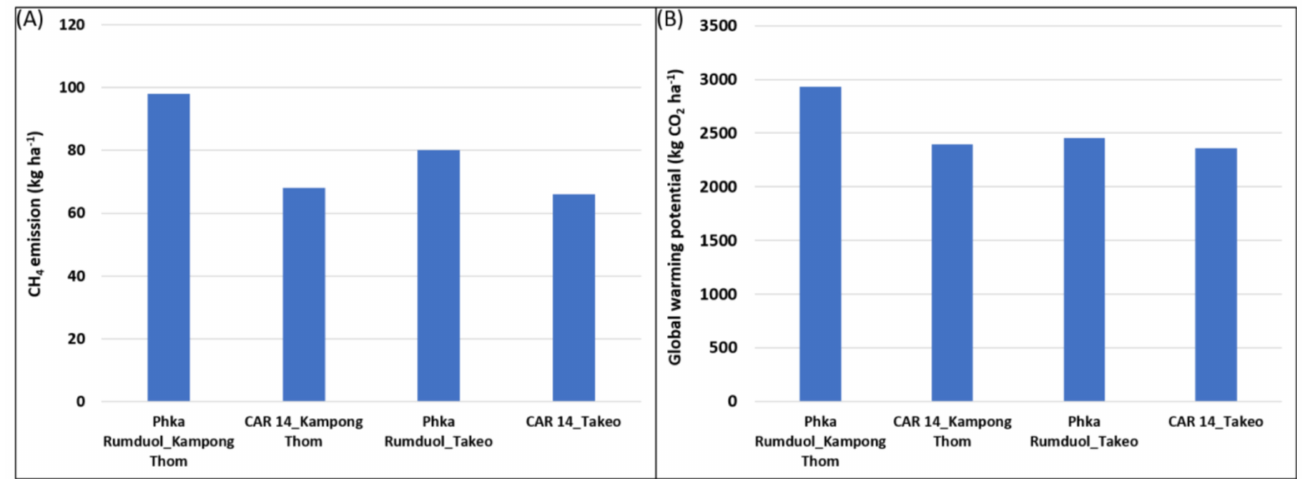
Figure 3. ( A ) Comparison of methane emissions and ( B ) global warming potential (GWP) using the two most cultivated varieties in Kampong Thom and Takeo,